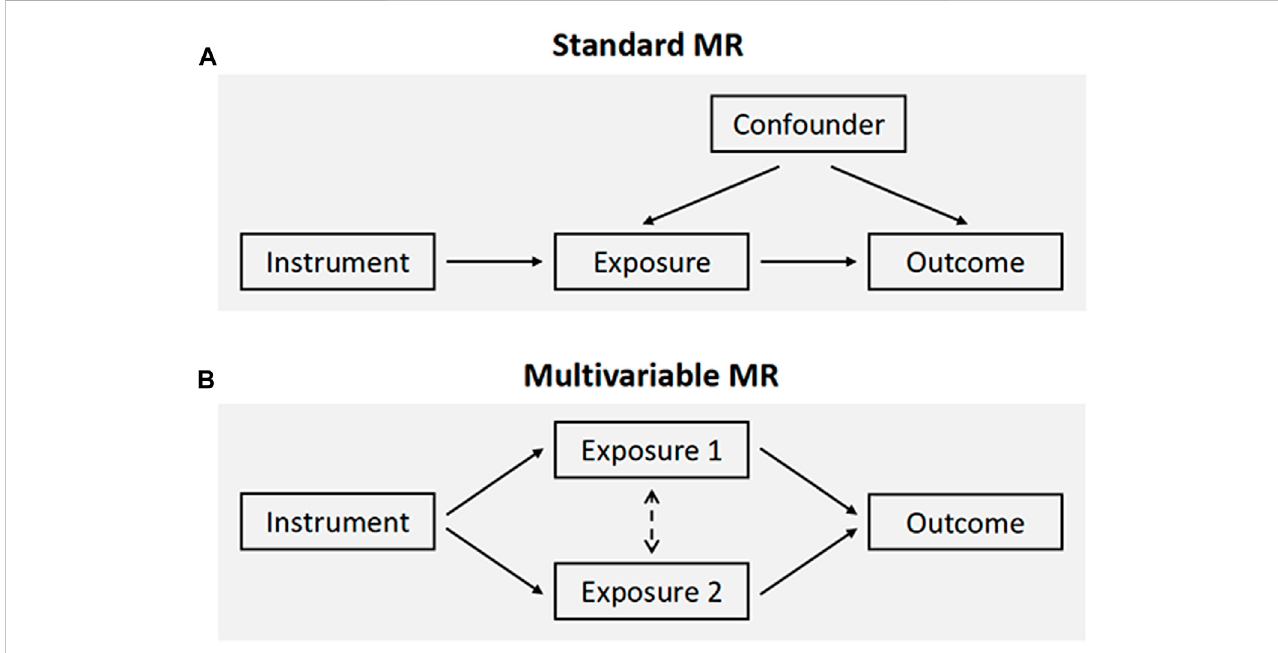
FIGURE 1 Schematic overview of the study design. (A) The standard MR framework. MR relies on three core assumptions for causal inference: the genetic variants are associated with the exposure (relevance assumption), are independent of confounders (independence assumption), and affect the outcome through the exposure of interest only (exclusion restriction assumption, also known as the “ no pleiotropy ” ). (B) MultivariableMR, an extension of univariable MR, leverages genetic instruments associated with multiple correlated exposures to jointly estimate the independent effect of each of the exposures on the outcome. MR, Mendelian